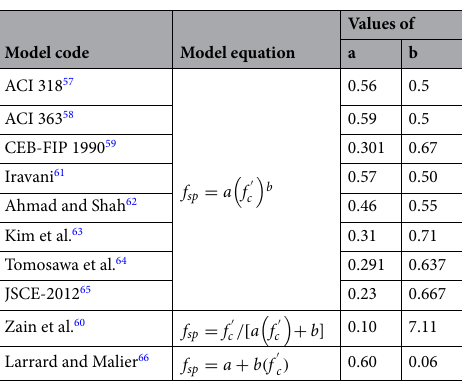
Table 5. Model equation and values of a and b corresponding to existing model